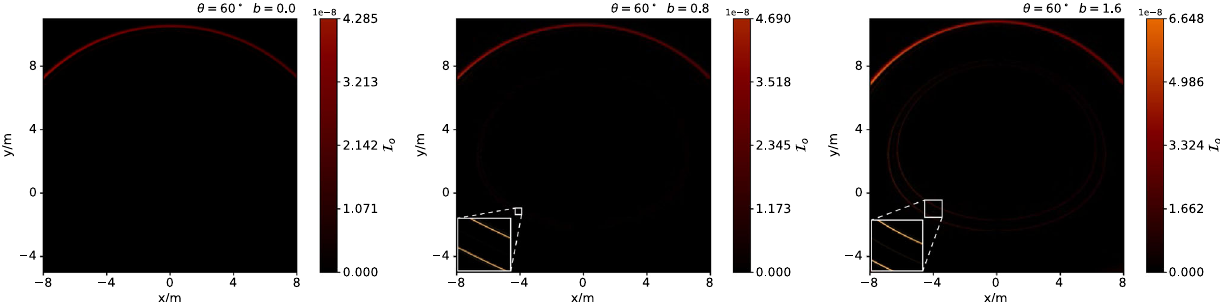
Fig. 3 Intensity distribution curve with magnetic dipole parameter b along the line y = 0. The gray dashdot line in each plot corresponds to theSchwarzschildcase.Theleftpaneldenotestheintensityofsource I s